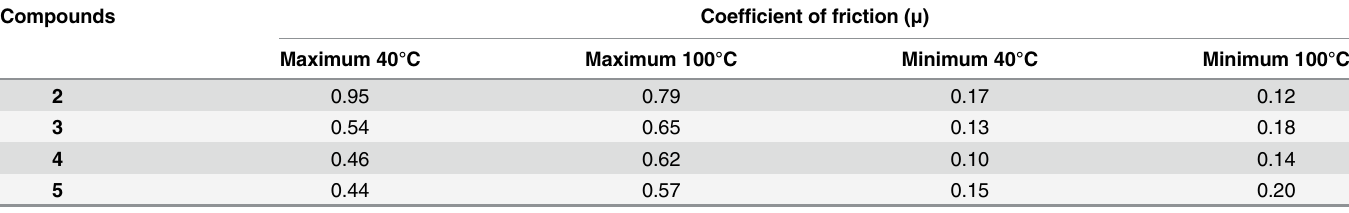
Table 5. Tribological characteristics of synthesis